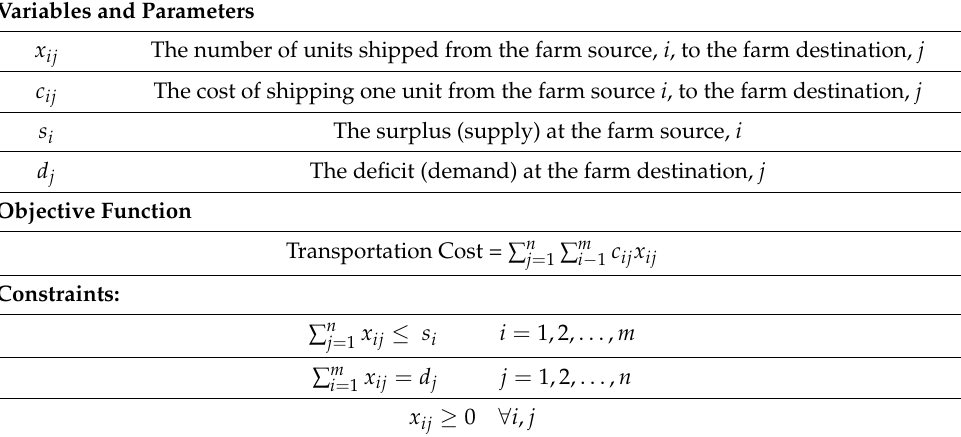
Table 1. Produce optimization model for the micro supply chain among the farms. Variables and